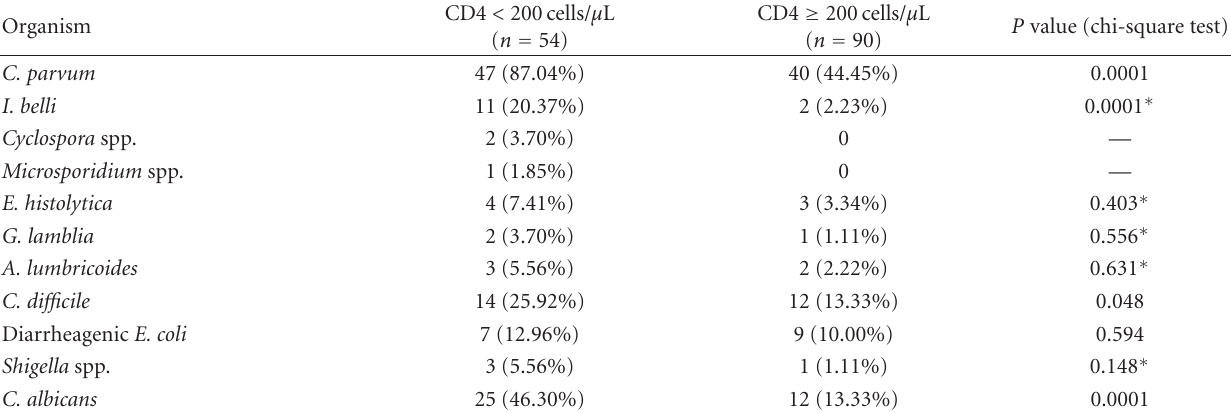
Table 5: Frequency of enteropathogens in relation to CD4 counts in HIV seropositive cases ( n = 144).